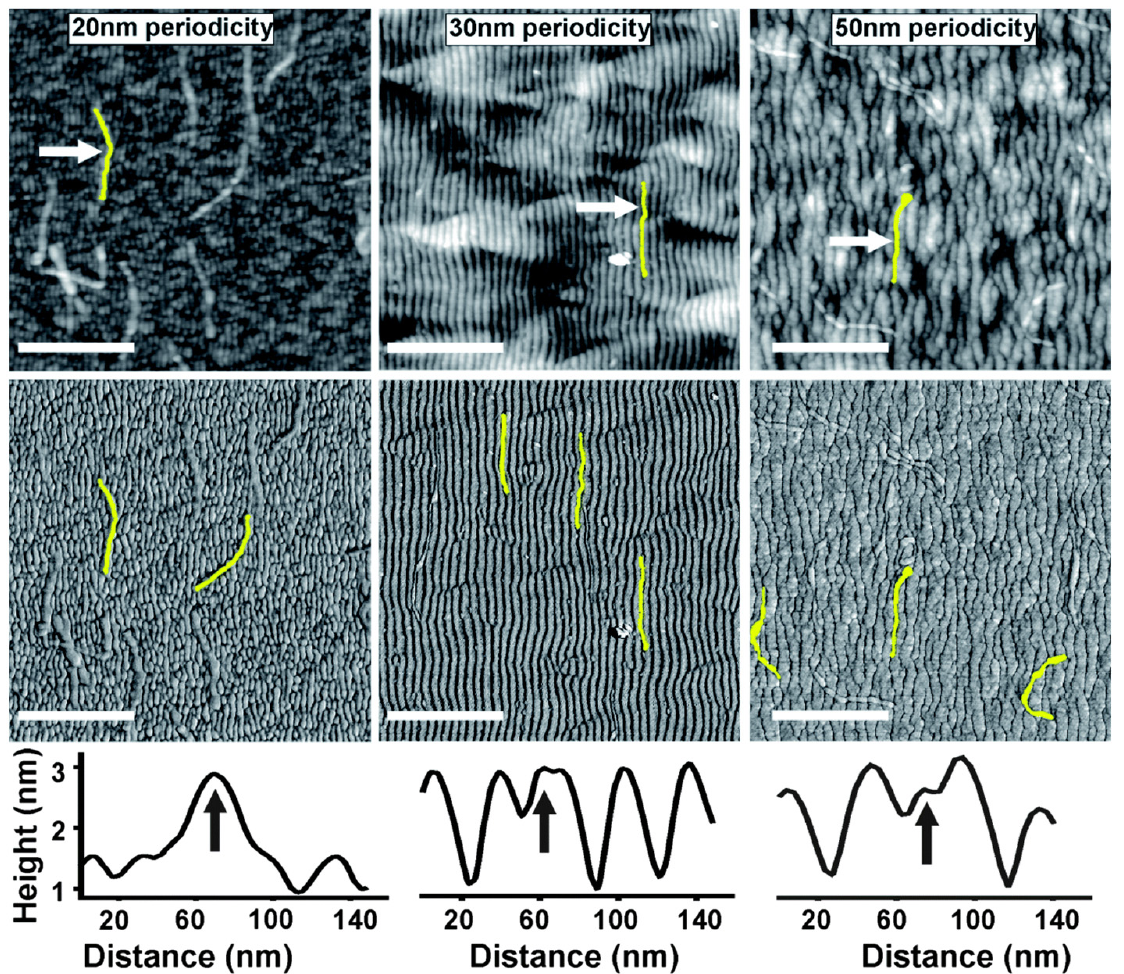
Figure 5. AFM height ( first row ) and corresponding phase images ( middle row ) of DNA origami nanotubes adsorbed at nanorippled SiO x /Si surfaces with periodicities of 20 ( left ), 30 ( center ), and 50 nm ( right ). Selected DNA origami nanotubes are highlighted in yellow. The scale bars are 500 nm. The height profiles in the bottom row were taken perpendicular to ripple orientation at the positions indicated by the white arrows in the corresponding height images. The black arrows indicate the positions of the nanotubes in the height profiles. Reproduced from Ref. [114] with permission from The Royal Society of Chemistry.